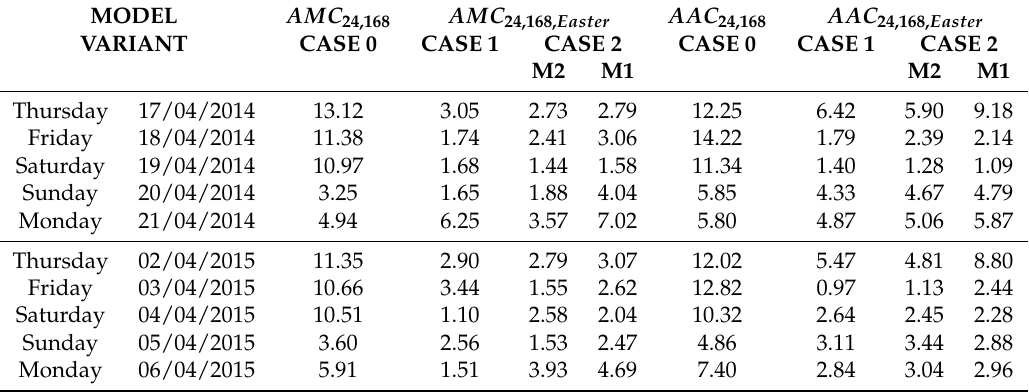
Table 5. Mean Absolute Percentage Error (MAPE) for AMC 24,168 , AMC 24,168, Easter , AAC 24,168 , and AAC 24,168, Easter for different periods and optimisation methods.